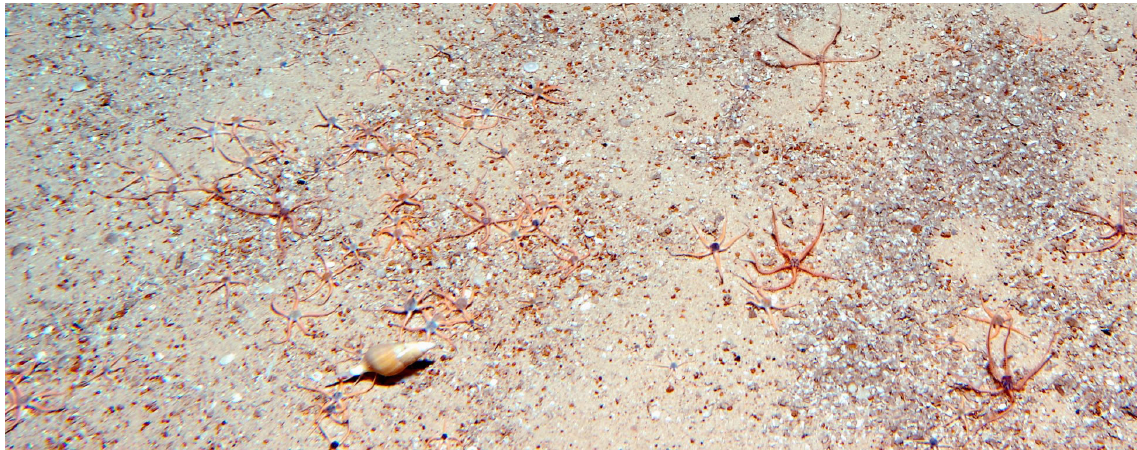
Fig. 47. A gastropod of the genus Colus Röding, 1798 (probably C. gracilis (da Costa, 1778)), roaming a sedimentary bottom of the summit platform where there are abundant brittlestars and small bivalves of the genus Limopsis Sasso, 1827 (probably L. minuta (Philippi, 1836), white dots in the photograph). Photo: Indemares project;